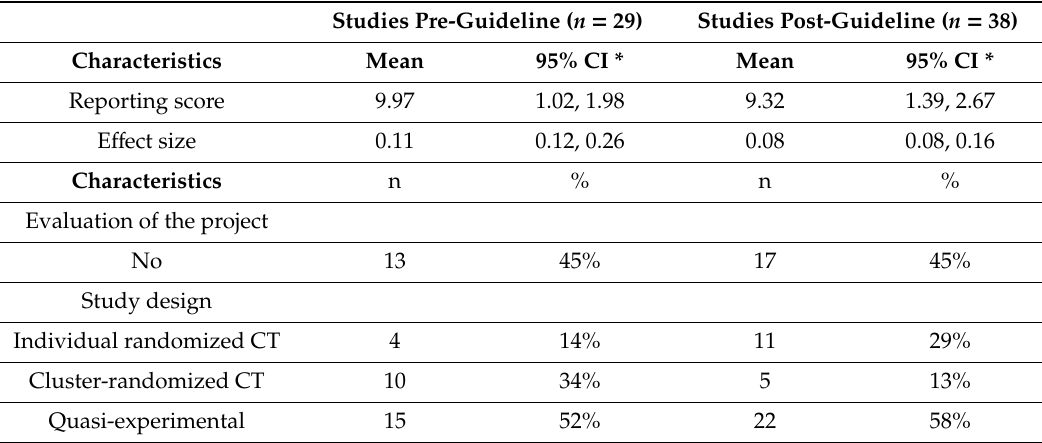
Table 2. Characteristics of the studies calculated the e ff ect size.